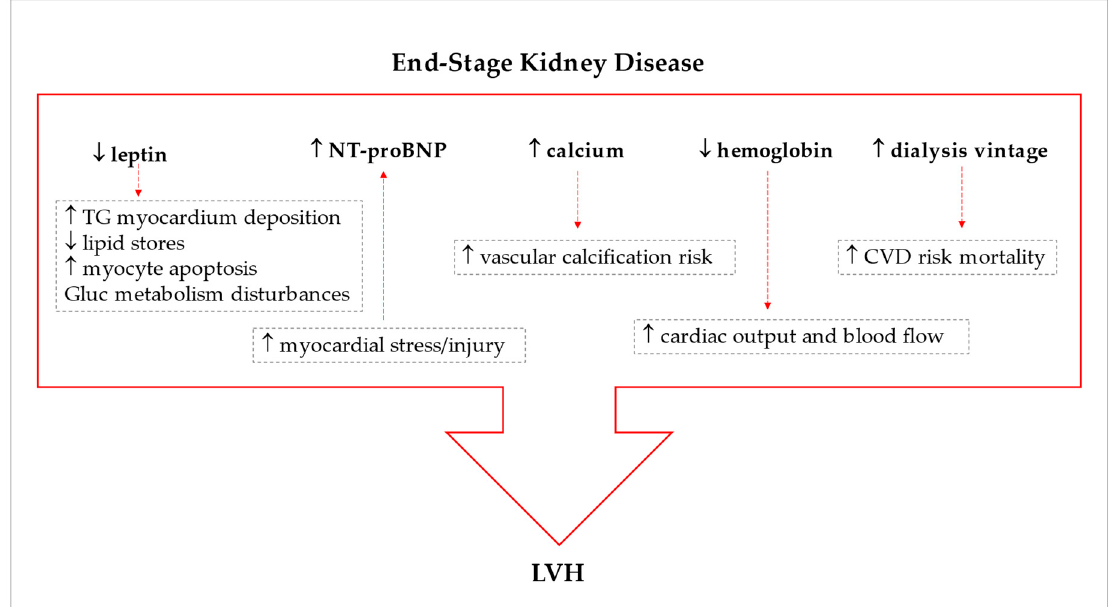
Figure 4. Schematic view of the predicting biomarkers of left ventricular hypertrophy and potential underlying mechanisms in end-stage kidney disease patients on dialysis, the red arrows indicating potential mechanistic consequences. CVD, cardiovascular disease; Gluc, glucose; LVH, left ventricular hypertrophy; NT-proBNP, N-terminal pro B-type natriuretic peptide; TG, triglycerides. ↑ , higher/increased; ↓ lower/decreased.